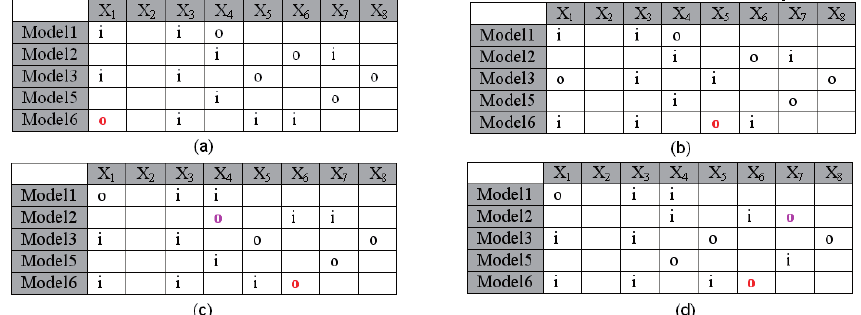
Fig. 5. Incidence matrices with the following variables chosen as output from model6: (a) X 1 ; (b) X 5 ; (c) X 6 then X 4 ; (d) X 6 then X 7 .